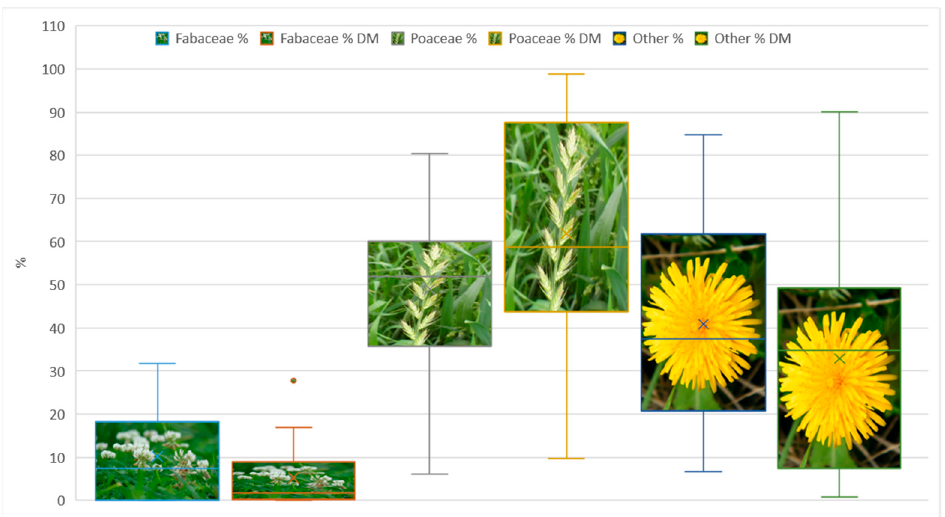
Figure 2. Botanical composition of the sample taken for analysis (numerical contribution of different species and DM%). Fabaceae % = % of total plants observed along the transect, Fabaceae % DM = % of Dry Matter, Poaceae % = % of total plants observed along the transect, Poaceae % DM = % of Dry Matter, Other% = % of total plants observed along the transect, Other% DM = % of Dry